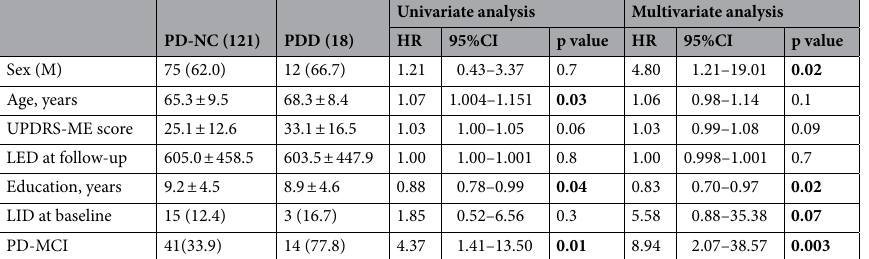
Table 4. Predictors of Parkinson’s disease-dementia at follow-up. PD-NC: Parkinson’s disease-normal cognition; PDD: Parkinson’s disease-dementia; M: men; UPDRS-ME: Unified Parkinson’s Disease Rating Scale-Motor Examination; LED: levodopa equivalent dosage; LID: levodopa induced dyskinesia; PD-MCI: Parkinson’s disease-mild cognitive impairment.